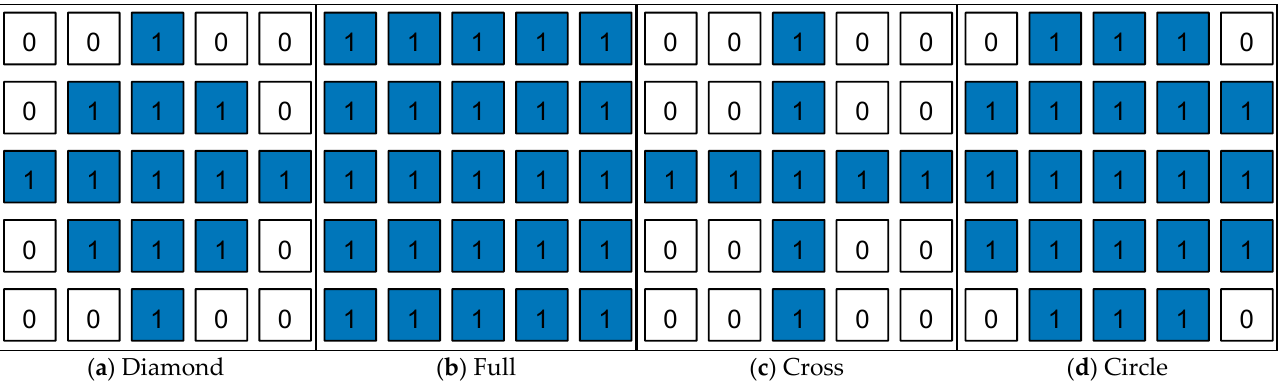
Figure 5. Using different sized kernels to process hollow images.